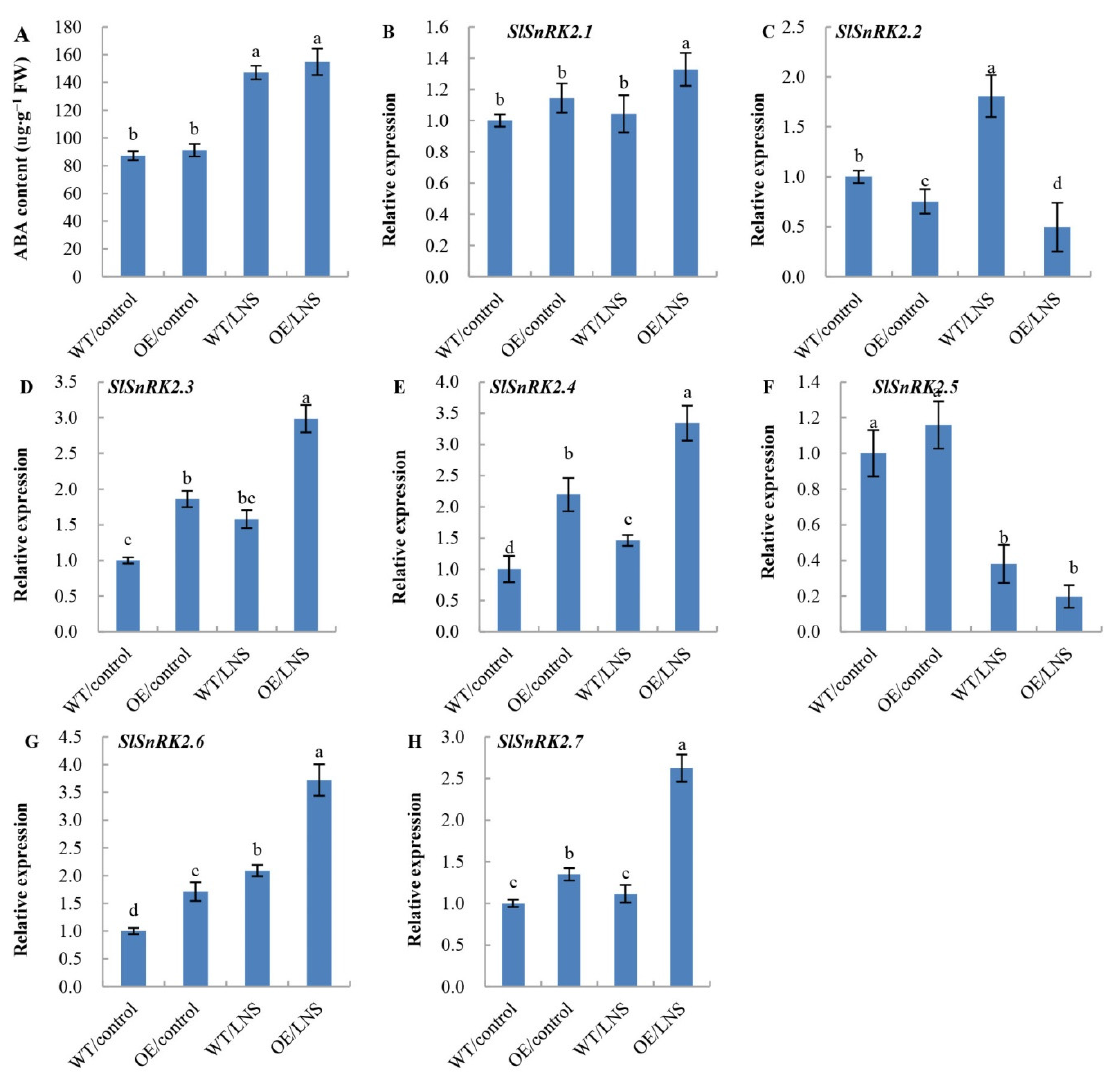
Figure 4. Activation of TOR by Glc inhibits autophagy. ( A ) Autophagosomes by MDC staining in leaves of WT and OE plants. Autophagosomes by MDC staining are shown as green signals. Bars: 50 μ m. ( B ) The number of autophagosomes by MDC staining per image in ( A ) was quantified to calculate the autophagic activity. Different lowercase letters indicate significant differences ac- cording to Duncan’s multiple range test ( p < 0.05).